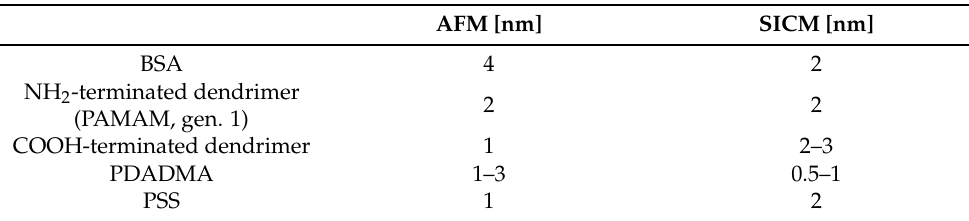
Figure 2. Characterization of molecular landscapes (in this case NH 2 -terminated (PAMAM) den- drimer monolayers) on glass upon µ CP. ( a ) AFM-topography image of 20 µ m wide molecule stripes with 20 µ m spacing in between them in ambient condition (air). Bright colors indicate topographically high locations. The white spots partly originate from instrumental noise. ( b ) Corresponding Phase- image. One can see that topographically higher areas show lower absolute phase values than the lower areas. This indicates different mechanical properties between those areas and, therefore, points to different materials being present, namely NH 2 -terminated dendrimers and glass. ( c ) Fluorescence- image, obtained with a UV-filtercube in ambient. The molecule stripe patterns, which are bright, are macroscopically intact and seem to only occasionally show defects. ( d ) SICM-topography image of an NH 2 dendrimer/glass sample in PBS. Bright colors show higher areas similar to ( a ). The molecule stripes (high areas) stay intact in liquid environment. ( e ) Horizontal line profile of the AFM-topography image ( a ) averaged over the whole area. The height of the molecular layer (2nm) is prominently visible. Table 1. In ambient conditions (AFM) and in liquid (SICM) measured molecule layer thicknesses microcontact printed on